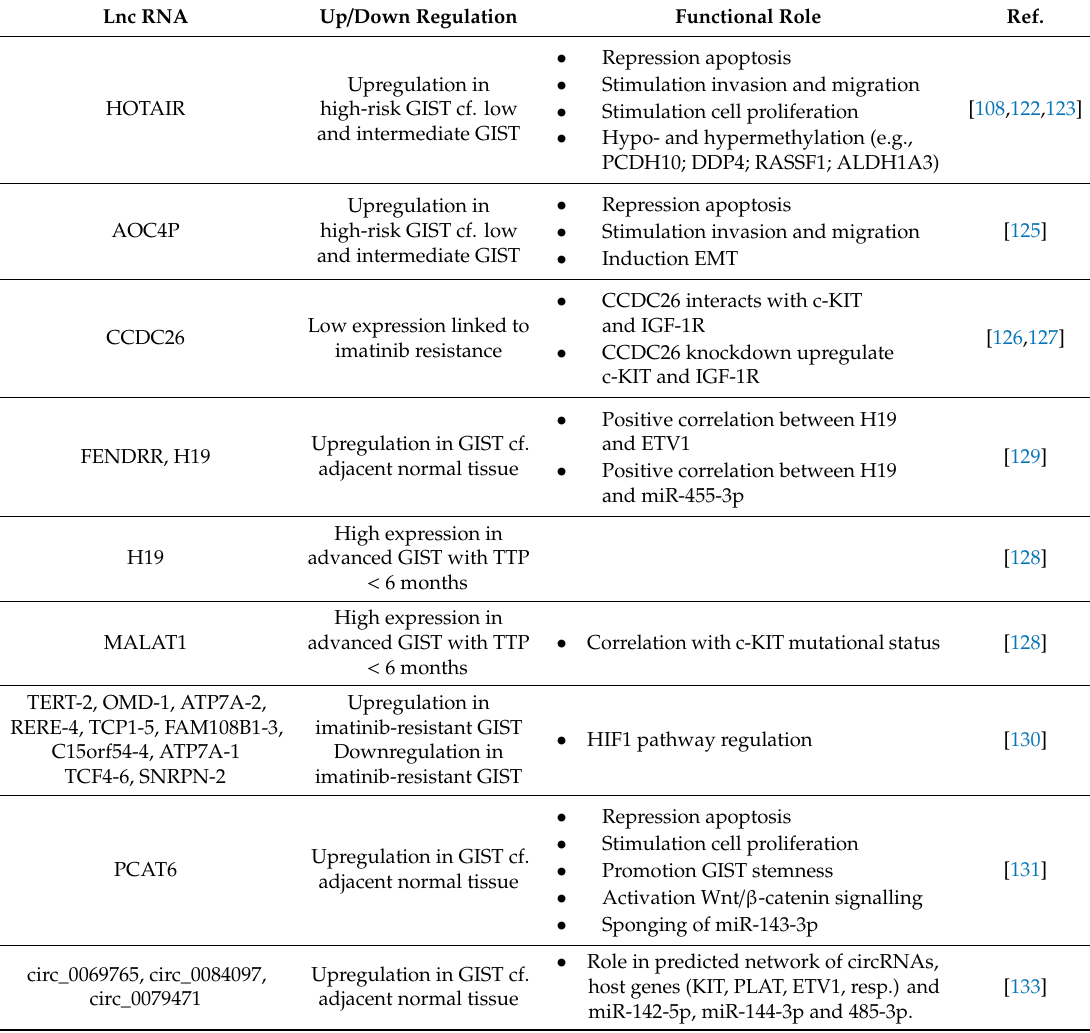
Table 4. Long non-coding RNAs in Gastrointestinal Stromal